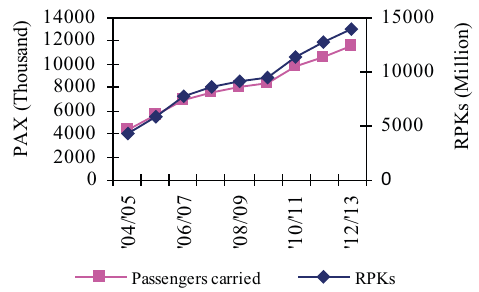
Fig. 2. Development of “Jetstar Australia’s” annual enplaned domestic passengers and revenue passenger kilometres (RPKs):